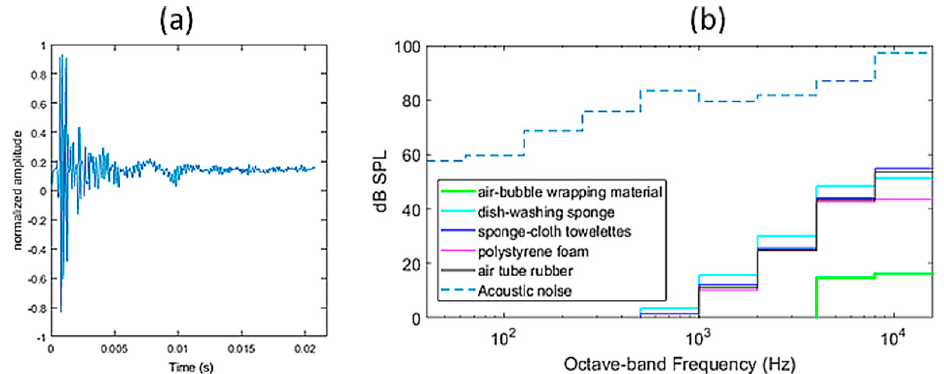
Figure 3. Typical rTMS click waveform in ( a ), and octave-band spectra of acoustic noise excitation (dashed line) and equivalent acoustic excitations of vibratory component (colored solid lines) when using layers of various materials between the coil and skull in ( b ).